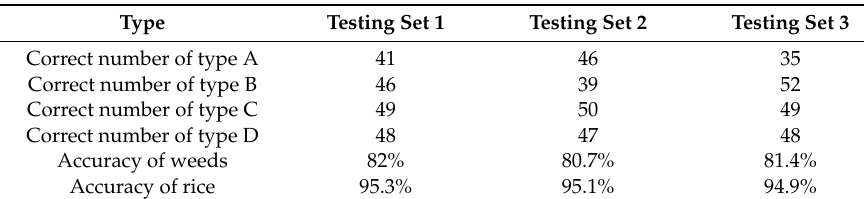
Table 9. Network accuracy results for group IV.